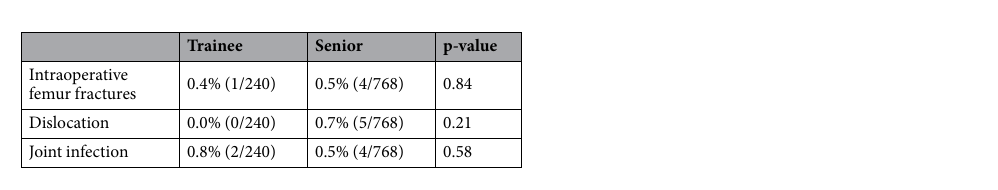
Table 2. Complication rates between the trainee and senior THAs * . * For categorical data values are given as relative and absolute